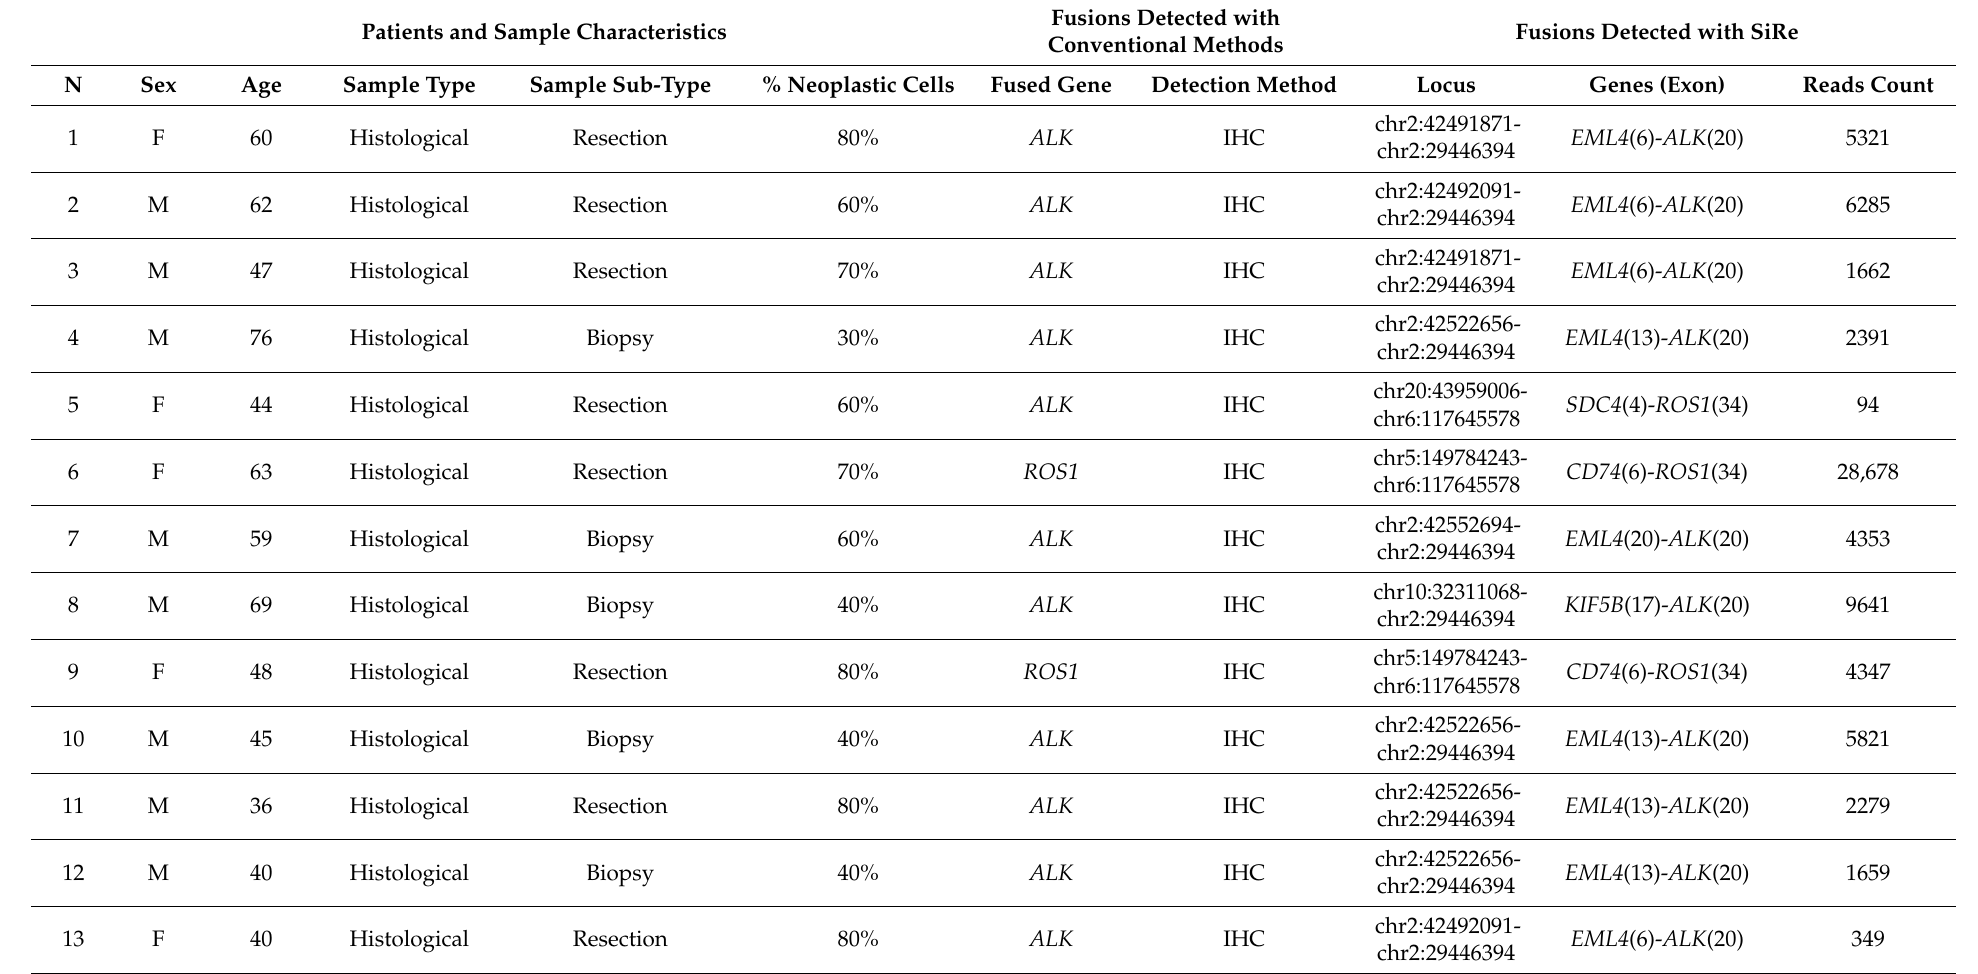
Table 1. Patients’ characteristics and SiRe